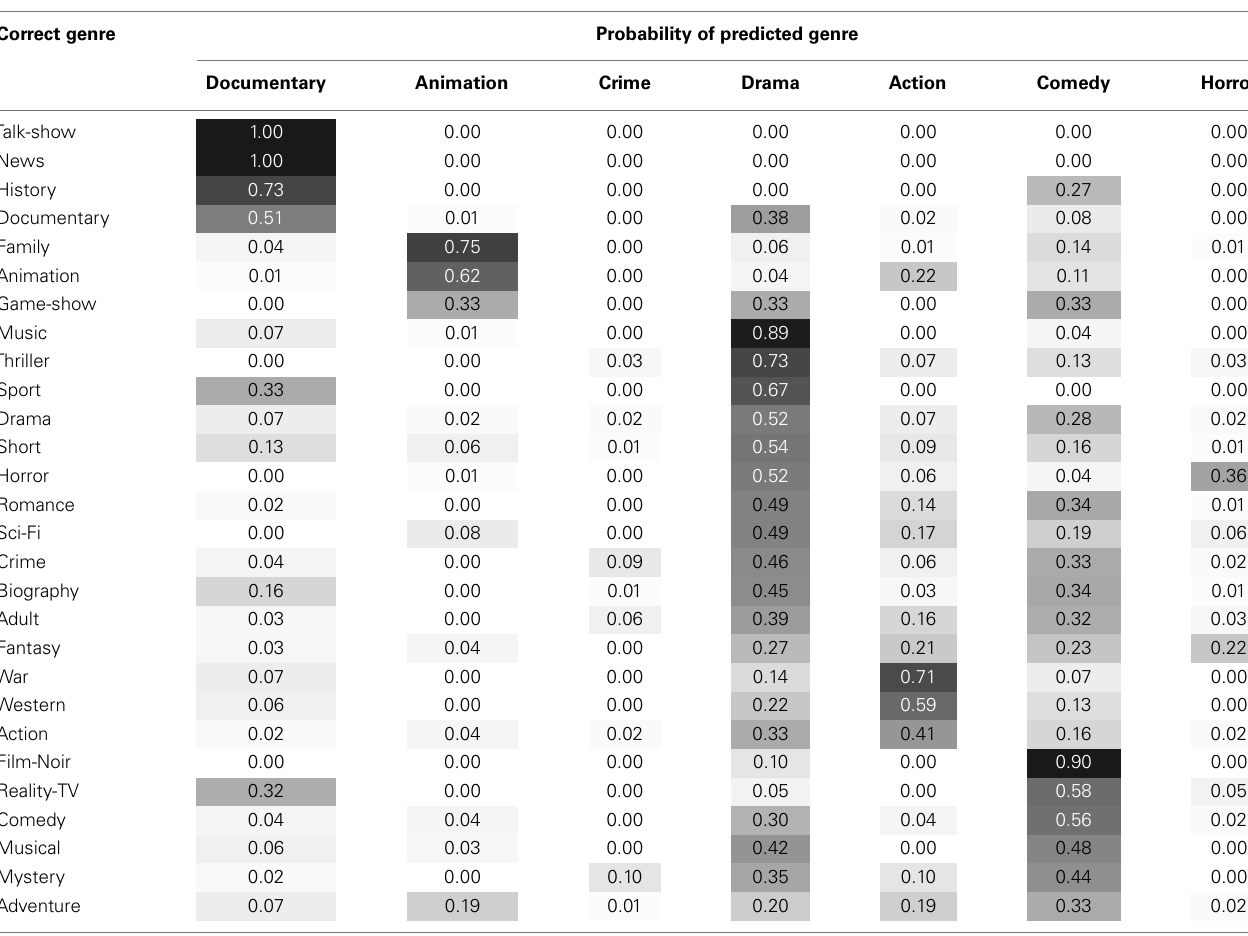
Table 5 | Probabilities of predicted genres in unary